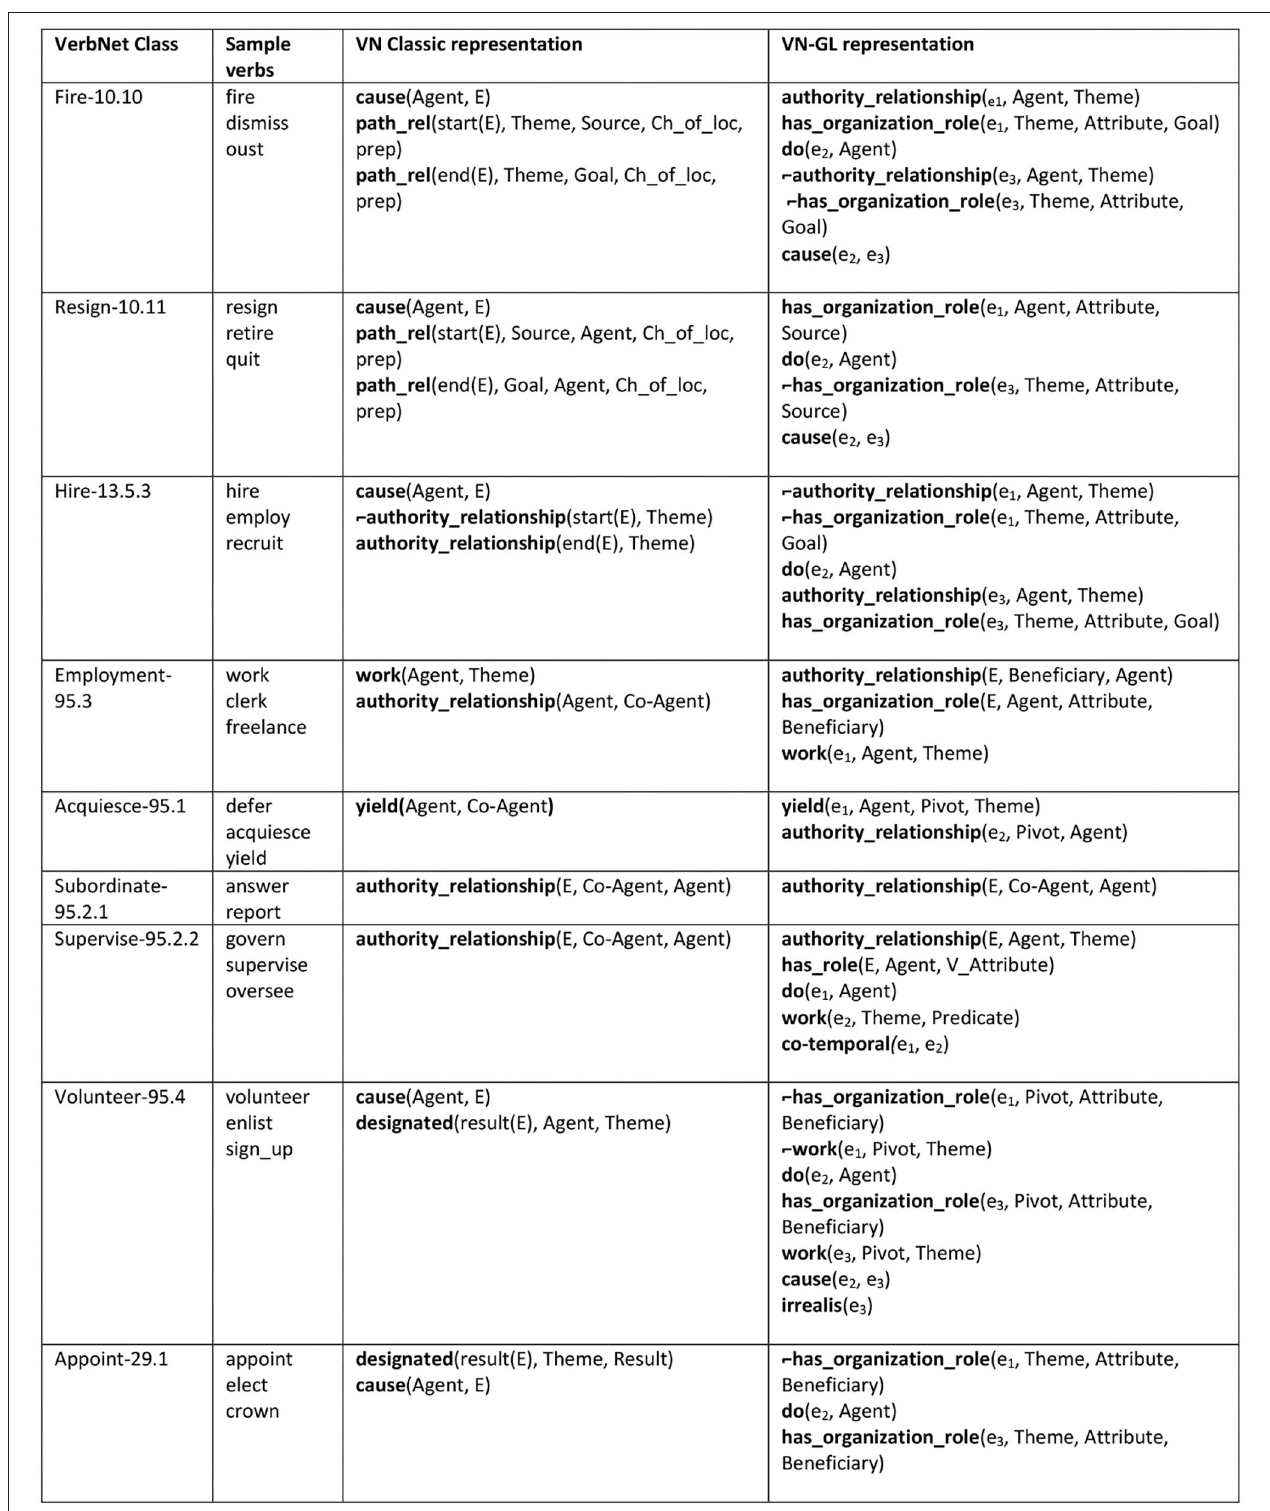
FIGURE 1 | The classes using the organizational role cluster of semantic predicates, showing the Classic VN vs. VN-GL representations.